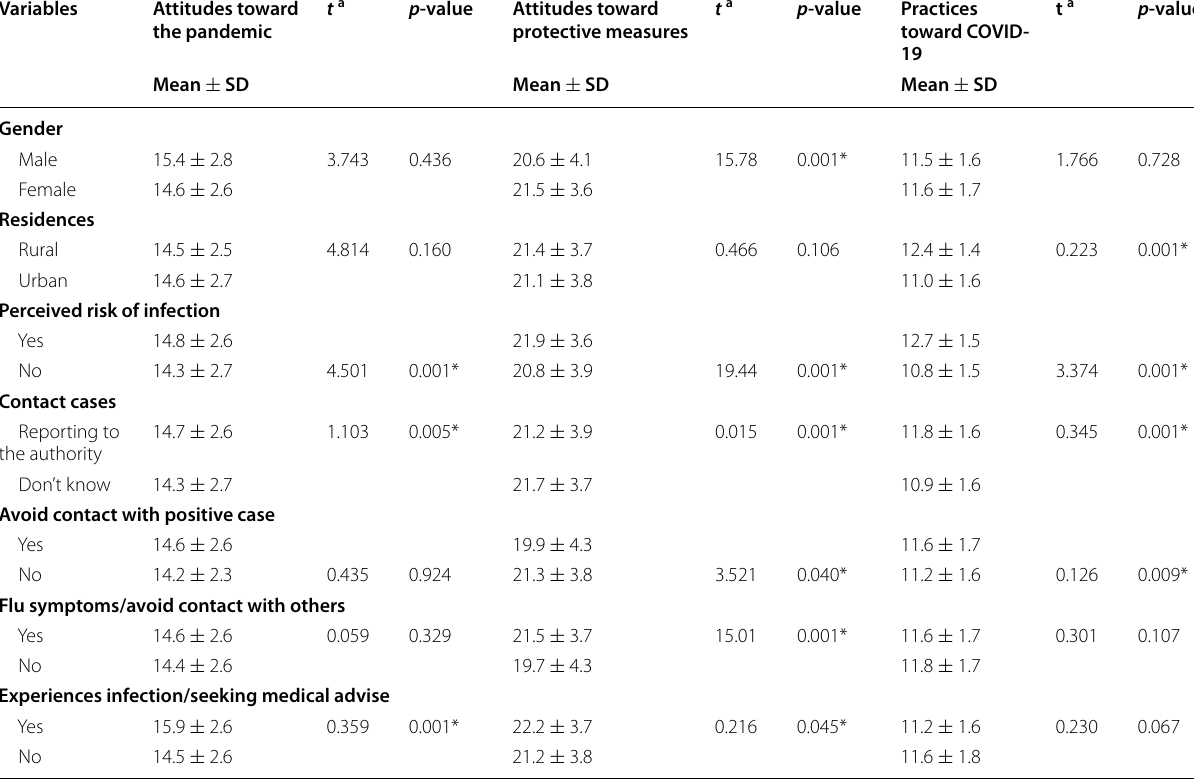
*Statistically significant at p <0.05 a Independent sample t -test